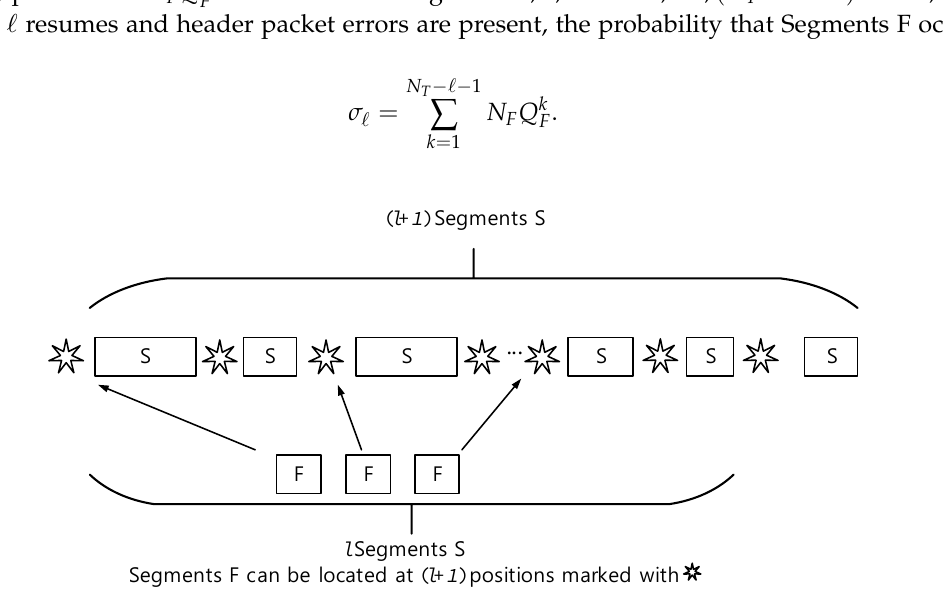
Figure 4. Header packets in errors are